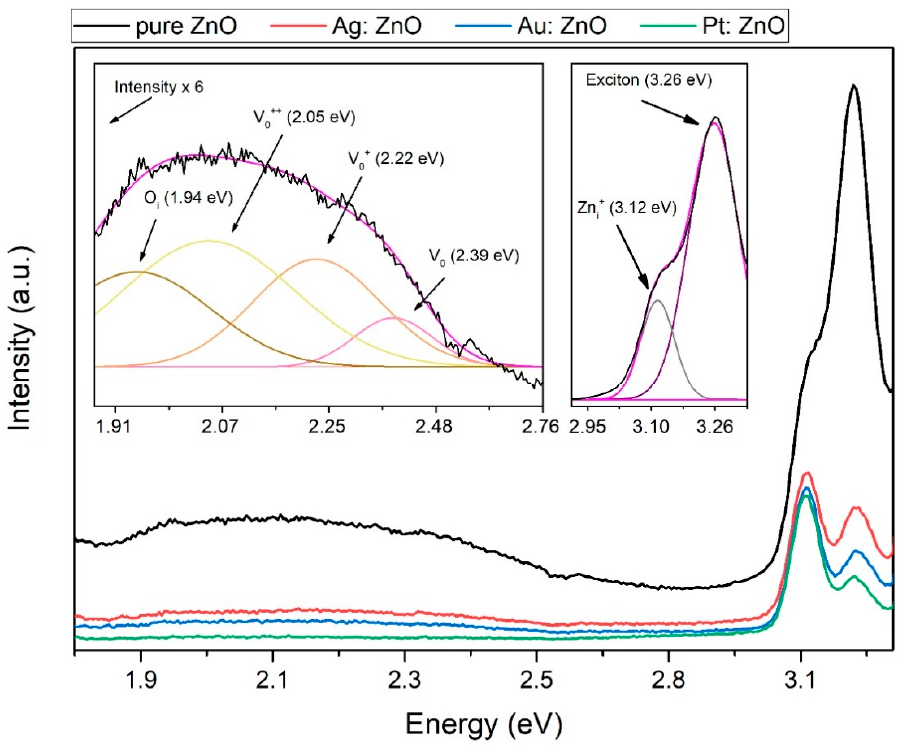
Figure 3. The photoluminescence (PL) spectra of pure and Ag, Au, and Pt doped ZnO NPs. In inset: Deconvolution plot in UV and visible part of PL spectrum (magenta line represent cumulative fit peak).